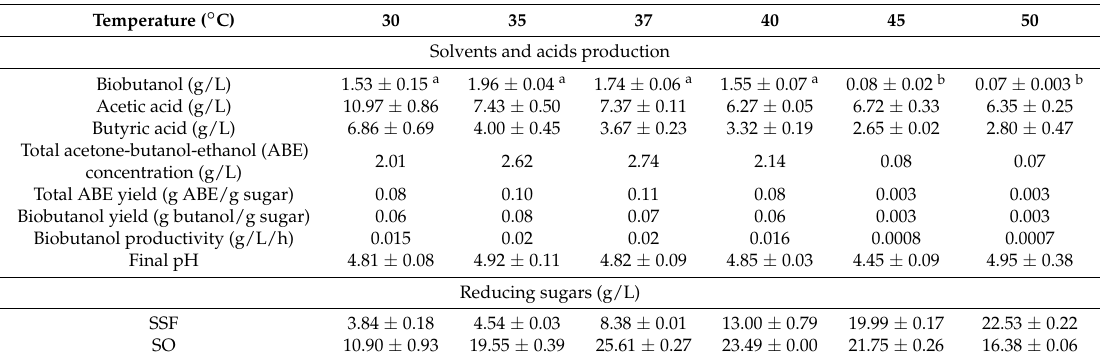
Table 1. Effect of temperature (30–50 ◦ C) on biobutanol production at initial pH 5.5, cellulase loading of 15 FPU/g-substrate and 5% ( w / v ) substrate on simultaneous saccharification and fermentation by Clostridium acetobutylicum ATCC